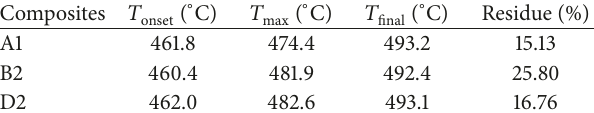
Table 2: Summary of TGA data of composites types A1, B2, and D2.